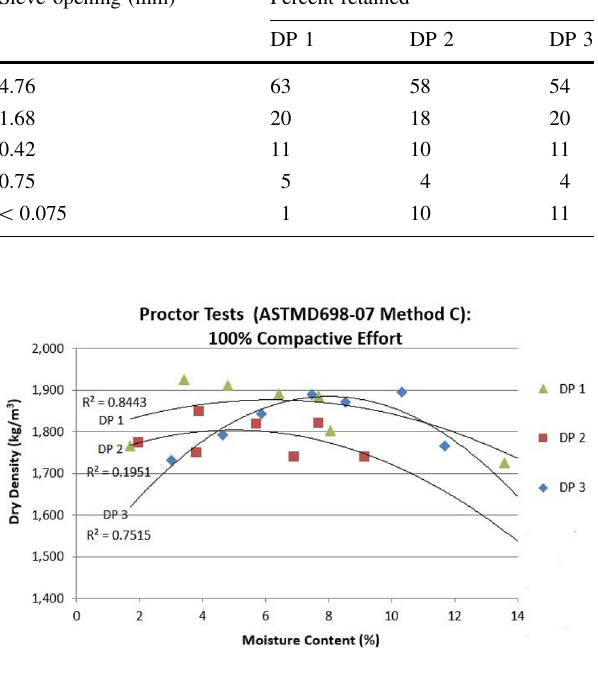
Fig. 2 Composite Proctor test results for DP 1, DP 2 and DP 3